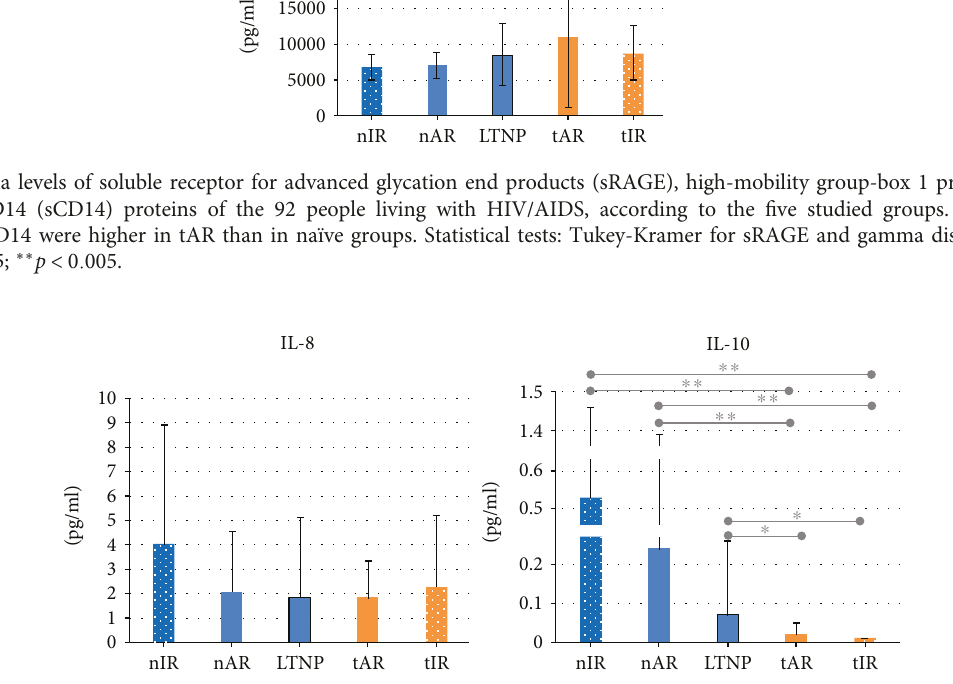
Figure 3: Plasma levels of IL-8 and IL-10 cytokines of the 92 people living with HIV/AIDS, according to the fi ve study groups. It is observed that IL-10 expression was lower in the LTNP and cART groups. Statistical tests: gamma distribution. ∗ p < 0 05 ; ∗∗ p < 0 001 .